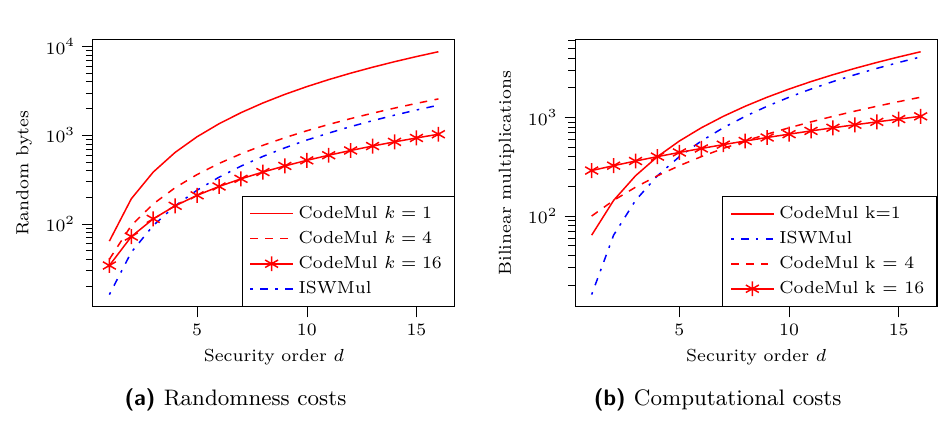
Figure 4: Estimated costs of 16 multiplications in